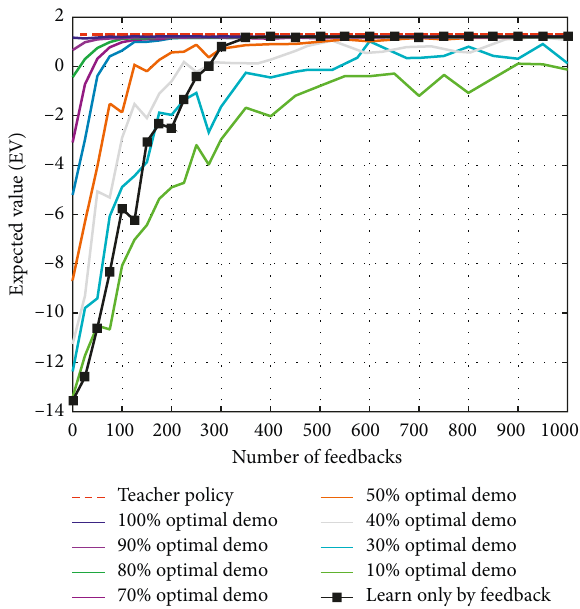
Figure 5: IRLDC’s stage-two performance in face of abundant and different demonstration optimality levels in stage-one (points “A1”, ... , “A8” and “B10” in Figure 3) and the number of evaluative feedbacks. The black curve has no initial demonstration (point “C” in Figure 3).